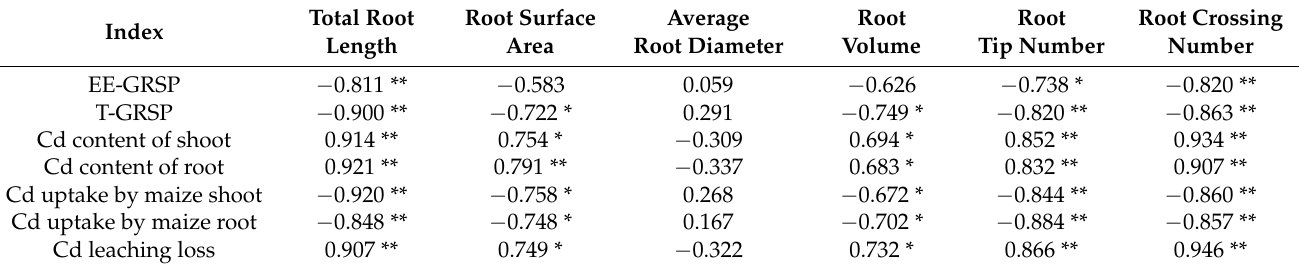
Table 4. Correlation between root morphology and GRSP, maize Cd accumulation and Cd leach- ing